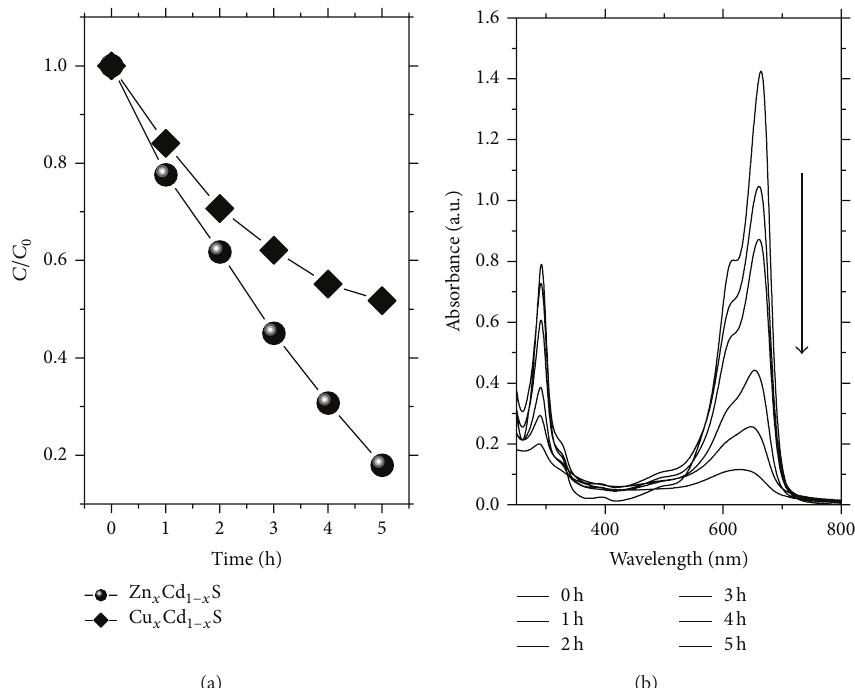
Figure 7: (a) Photobleaching of the normalized concentration of MB as a function of time for Zn 𝑥 Cd 1−𝑥 S and Cu 𝑥 Cd 1−𝑥 S. (b) Absorption spectra of the Zn 𝑥 Cd 1−𝑥 S thin